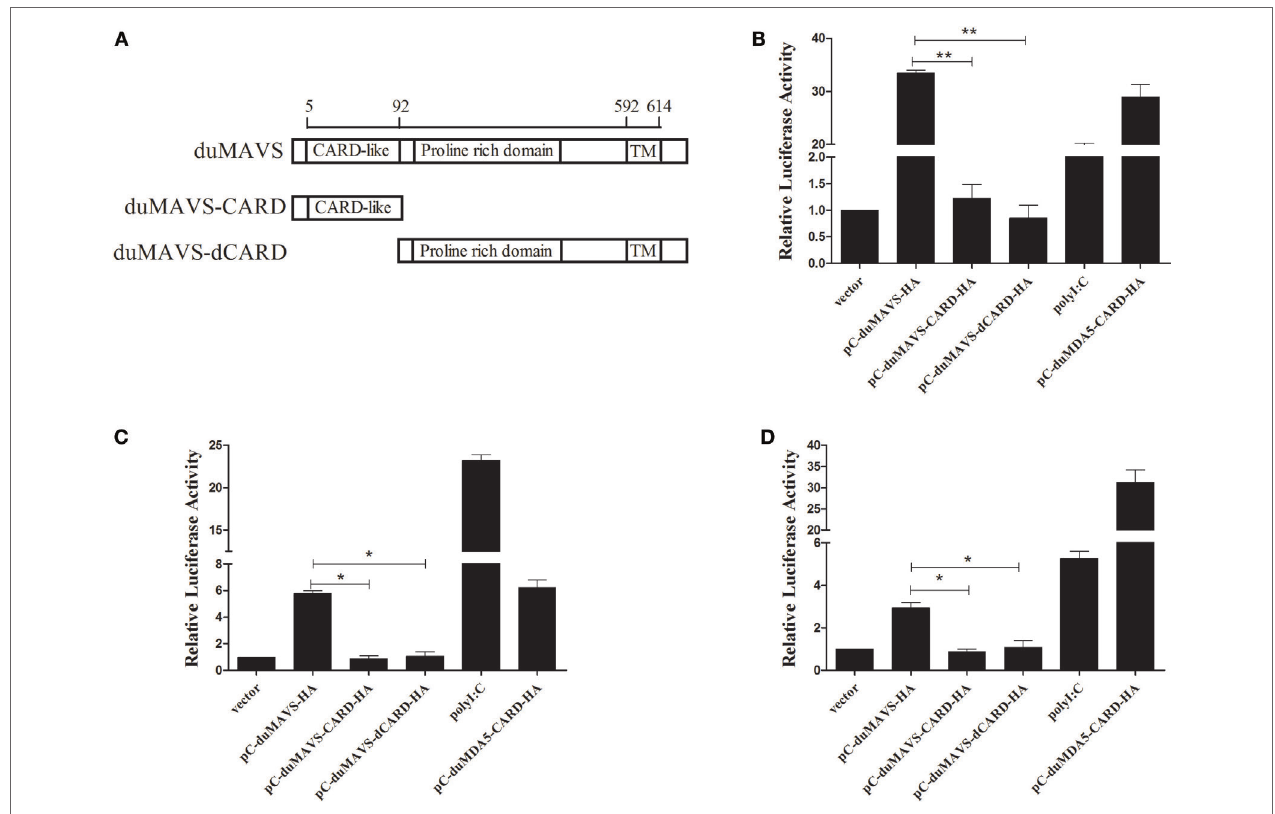
FigUre 4 | The results of iFn- β , nF- κ B, and irF7 dual-luciferase reporter gene assay . (a) Schema graph of the different duMAVS mutant plasmids used in this study. Various expressing plasmids (500 ng/well) were co-transfected with 100 ng/well reporter plasmids, (B) pGL3-IFN- β , (c) pGL3-NF- κ B, and (D) pGL3-IRF7 with 50 ng/well pRL-TK plasmid. Cells transfected with polyI:C (500 ng/well) and pC-duMDA5-CARD-HA (500 ng/well) were used as the positive control group. After 24 h, cells were harvested and luciferase activity was measured. Data were means from three independent experiments and each experiment was analyzed in triplicate. Student’s t test was performed to evaluate the differences. *Significant difference ( P < 0.05); **highly significant difference ( P < 0.01).